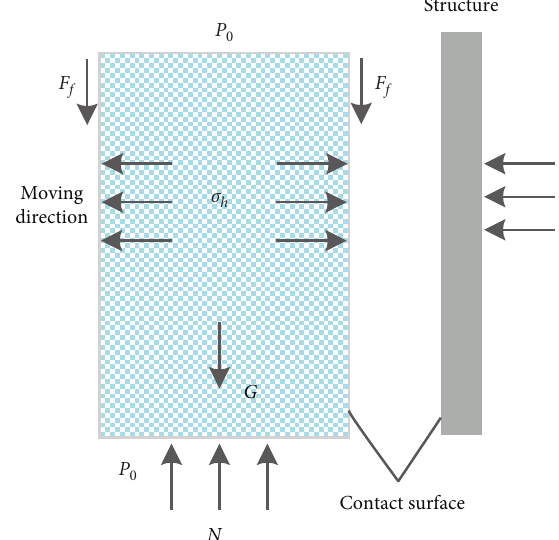
Figure 5: The distribution of elements for innovative design by mechanical analysis.